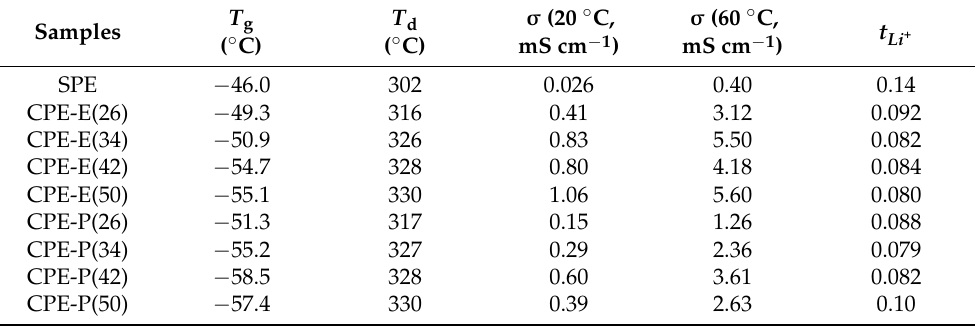
Table 1. Thermal properties, ionic conductivity ( σ ), and lithium ion transference number ( t Li + ) of different